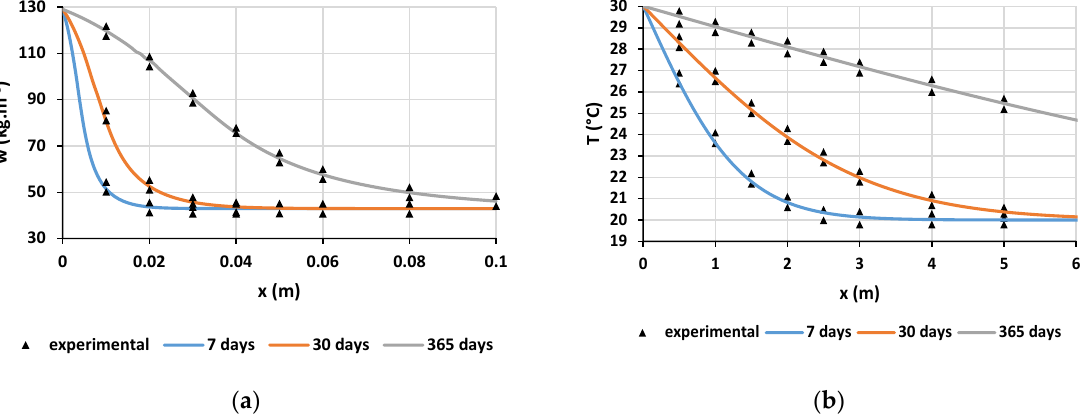
Figure 17. Comparison of the water content ( a ) and temperature profiles ( b ) obtained numerically (continuous lines) with those of the EN 15026 standard (triangles).